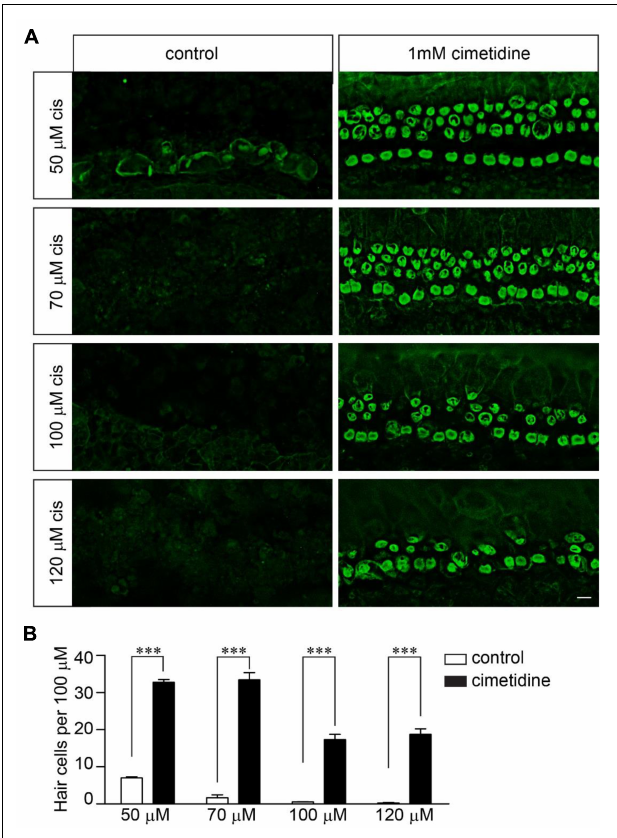
FIGURE 5 | Cimetidine protects Tmie − / − hair cells from cisplatin ototoxicity. (A) Cochlear explants were dissected from P3 Tmie − / − mice and then exposed to cisplatin at the indicated doses with/without 1 mM cimetidine for 2 days. The samples were fixed and labeled with an antibody against β 2-spectrin. Note, cimetidine protected the Tmie mutant hair cells from cisplatin ototoxicity. Scale bar: 10 µ m. (B) Numbers of hair cells per 100 µ m in the middle region of cochlea (5 mice per group, 50 µ M cisplatin; 4 mice per group, 70 µ M cisplatin; 3 mice per group, 100 µ M cisplatin; 3 mice per group, 120 µ M cisplatin). Data are represented as the mean ± SE. ∗∗∗ p < 0.001 by Student’s t -test.